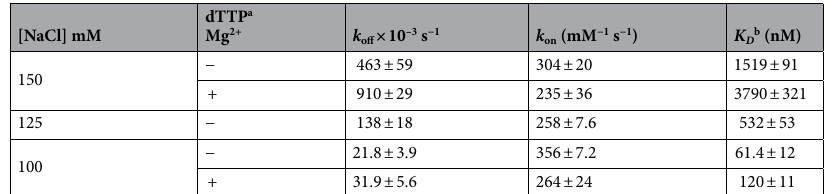
Table 1. Effect of salt concentration and dTTP/Mg 2+ on interaction of hPolε CD with DNA. Data are presented as mean ± SD (n = 3). a dTTP was added at a concentration of 50 µM, together with 5 mM MgCl 2 . b K d values are obtained by dividing k off by k on .